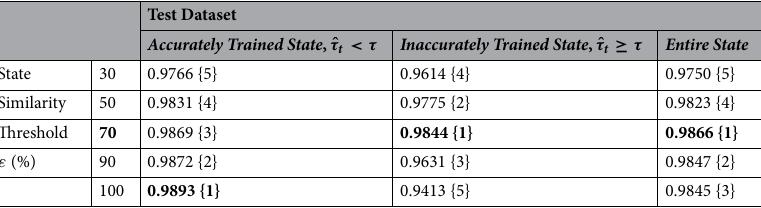
Table 1. Accuracy Comparison According to State Similarity Threshold. * Note . The value is the average accuracy. The value in {} is the ranking of the accuracy value in each column. Significant values are in bold.